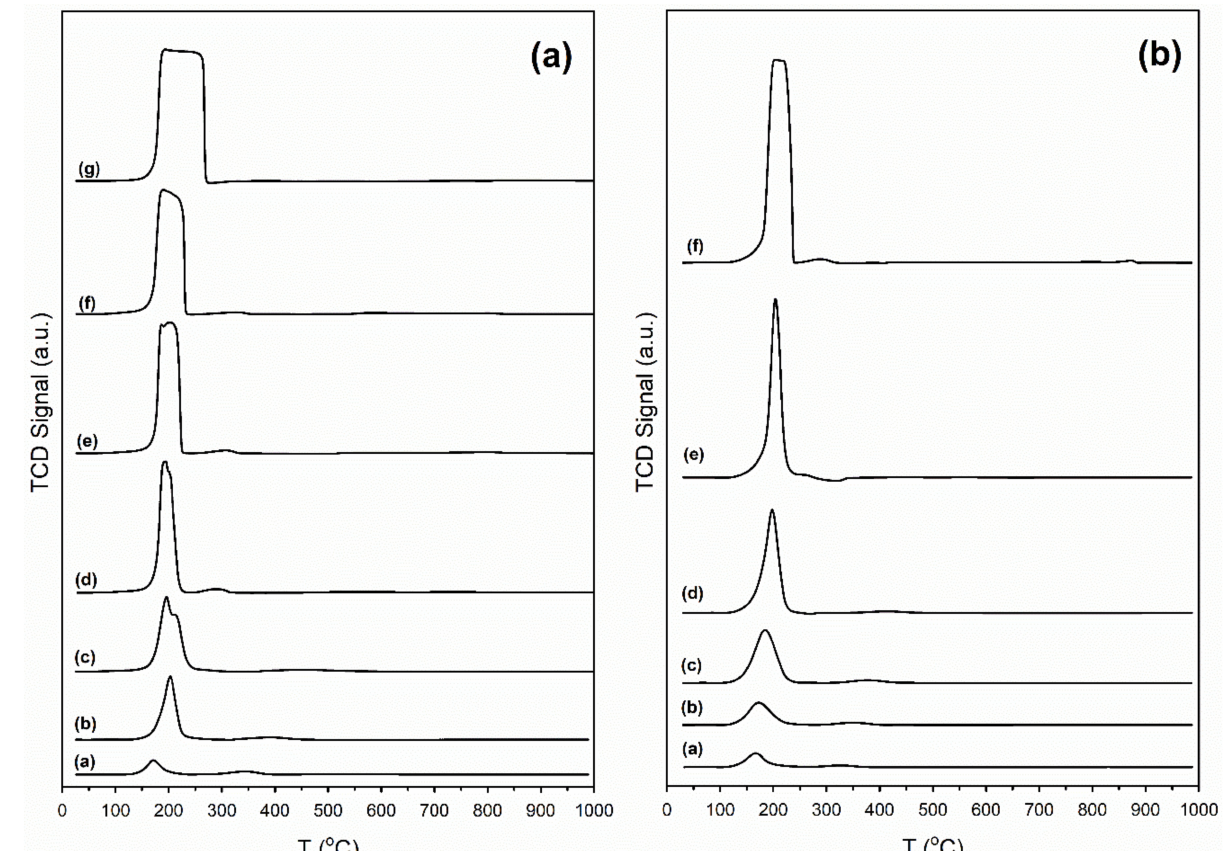
Figure 2. ( a ): TPR profiles for K-promoted catalysts: (a) 2% Pt/ZrO 2 , (b) 0.85% K-2% Pt/ZrO 2 , (c) 1.70% K-2% Pt/ZrO 2 , (d) 2.55% K-2% Pt/ZrO 2 , (e) 3.40% K-2% Pt/ZrO 2 , (f) 4.25% K-2% Pt/ZrO 2 , and (g) 8.50% K-2% Pt/ZrO 2 ; ( b ): TPR profile for Rb-promoted catalysts: (h) 0.55% Rb-2% Pt/ZrO 2 , (i) 1.86% Rb-2% Pt/ZrO 2 , (j) 2.79% Rb-2% Pt/ZrO 2 , (k) 4.65% Rb-2% Pt/ZrO 2 , and (l) 9.29% Rb-2% Pt/ZrO 2. Figure 2a reprinted from [48] with permission from Elsevier, copyright 2020. Figure 2b reprinted from [48] with permission from MDPI, copyright